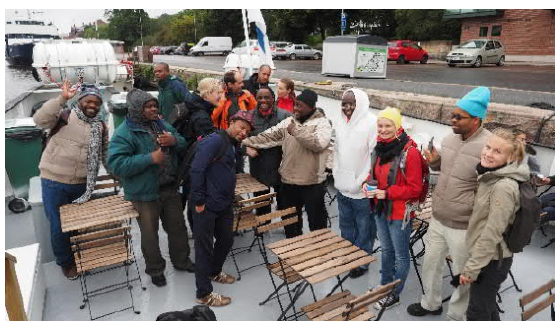
Figure 10. GEO-ICT team visiting the Archipelago